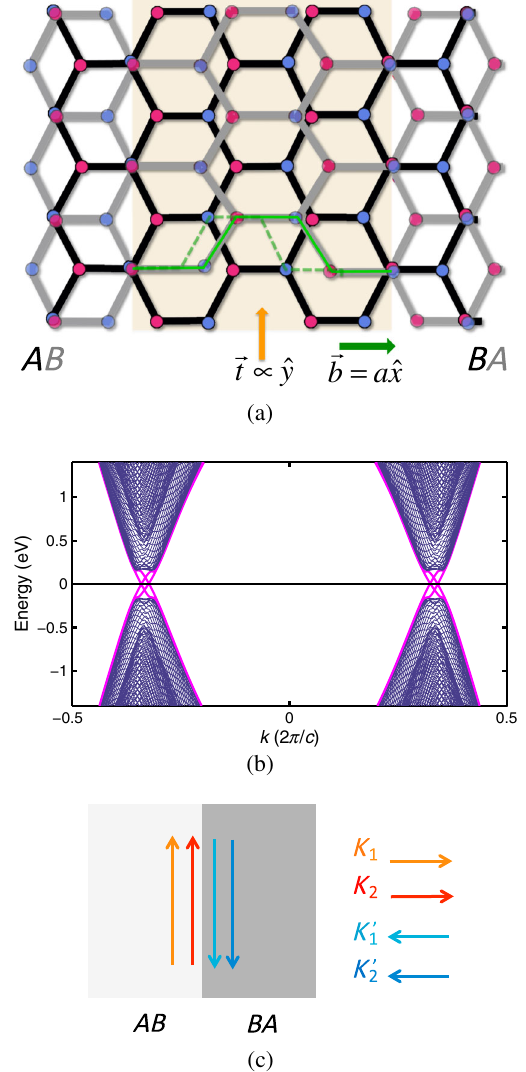
FIG. 2. A tight-binding study in the presence of abrupt AB - BA tilt boundaries in gated bilayer graphene. (a) Schematic repre- sentation of the domain wall under strain. The grey (black) lines denote the upper (lower) layer, and solid blue (red) circles denote the A ( B ) sublattice points. The tilt boundary along tangent vector ~t k ^ y is shaded. The Burger’s vector ~b ¼ a ^ x (green arrow) for interatomic spacing a accounts for the difference between the solid green line and the dashed green line. (b) The resulting band structure. The edge states are marked with magenta lines. (c) Schematics of valley-momentum-locked edge states at a tilt